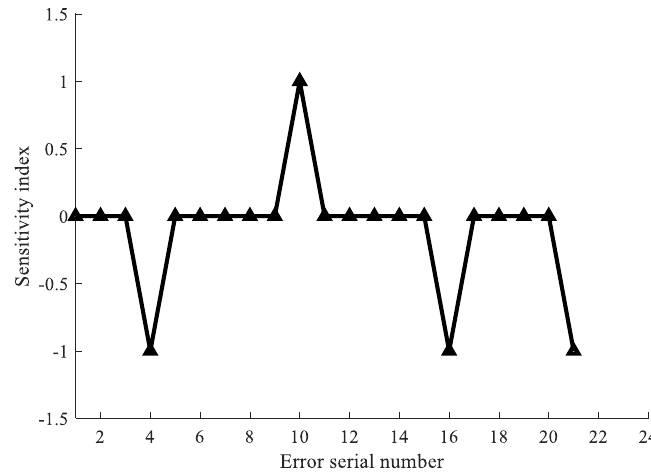
Figure 6. Sensitivity index of posture error in the x direction.